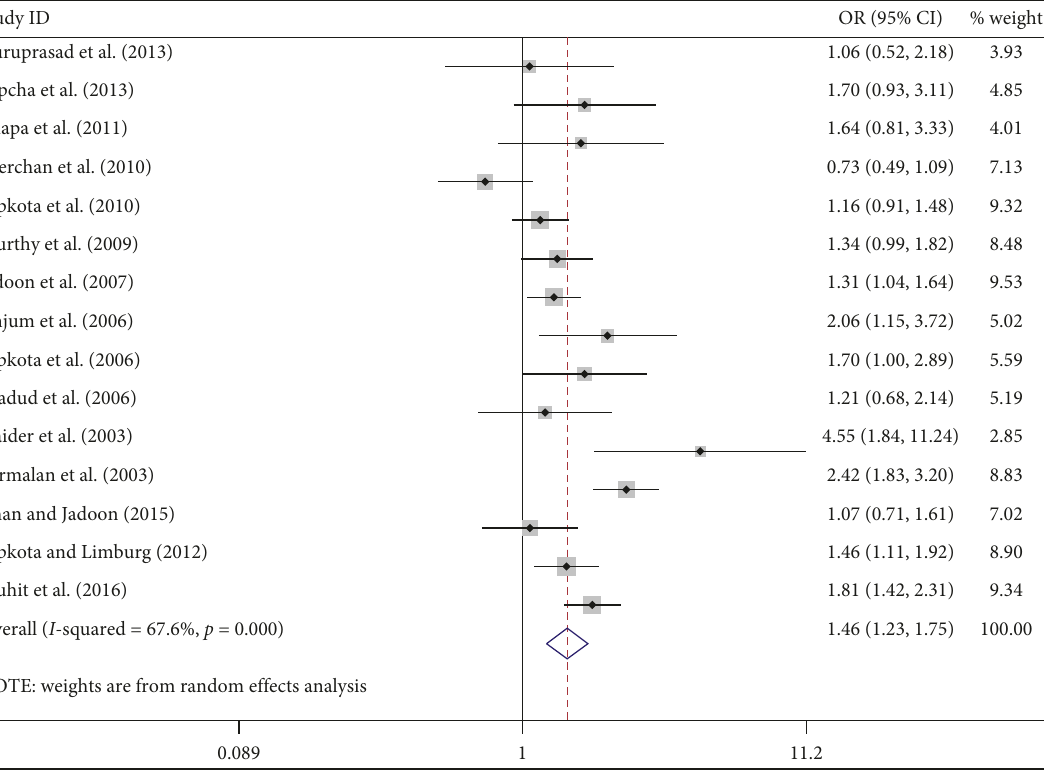
Figure 2: Forest plot showing the meta-analysis of CSC by sex on a person basis at visual < 3/60 level. CSC � cataract surgical coverage; OR � odds ratio; CI � confidence